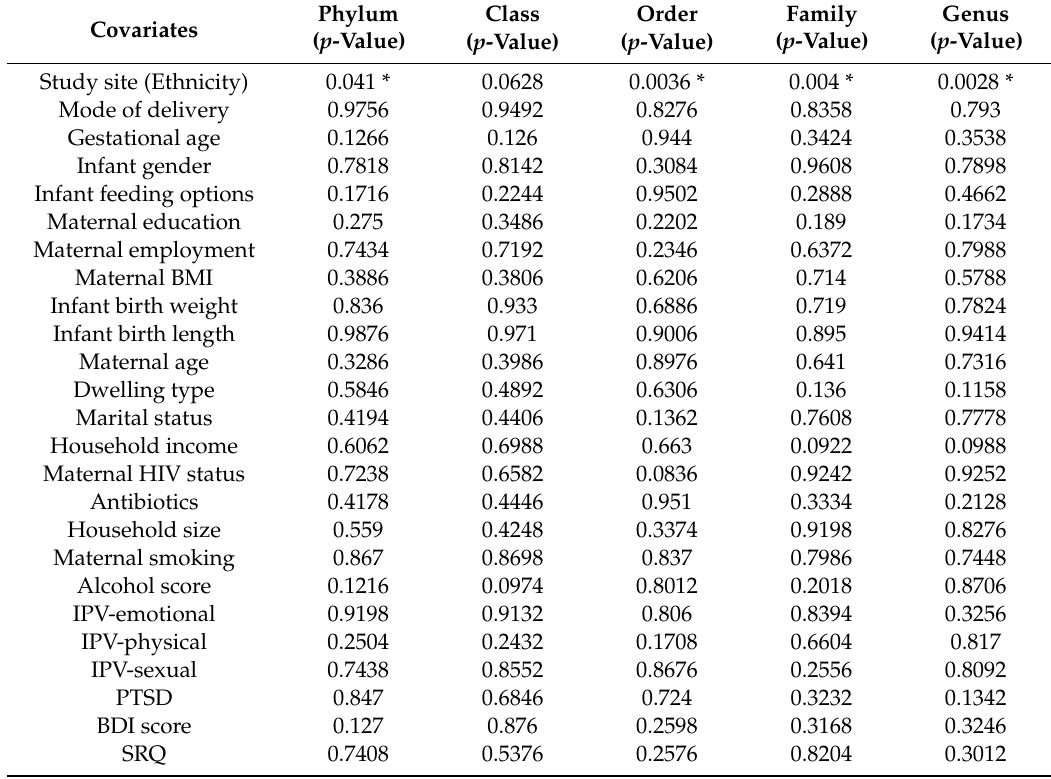
Table 1. Permutational multivariate analysis of variance (PERMANOVA) analyses of HBM bacteriome and its association with maternal demographic and psychosocial